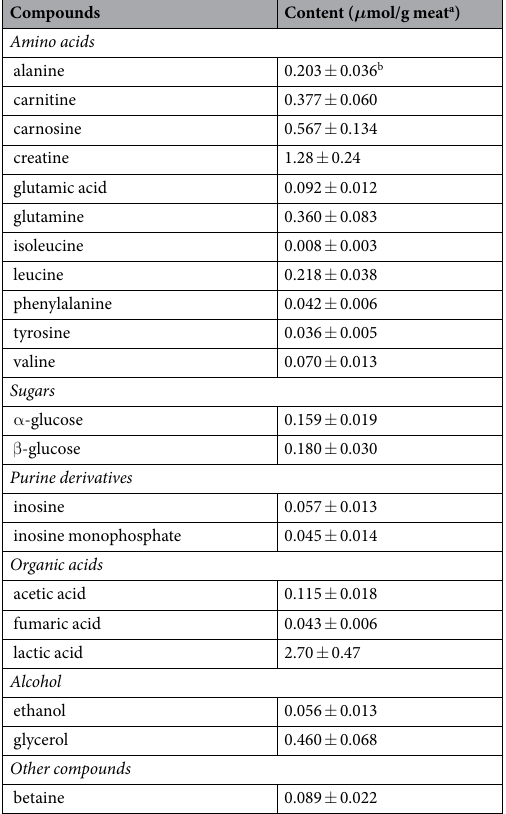
Table 1. Contents of the Compounds Detected in the D 2 O Extracts. a Sirloin from brand A Black heifers (2- week aging). b Mean ± standard deviation (n =